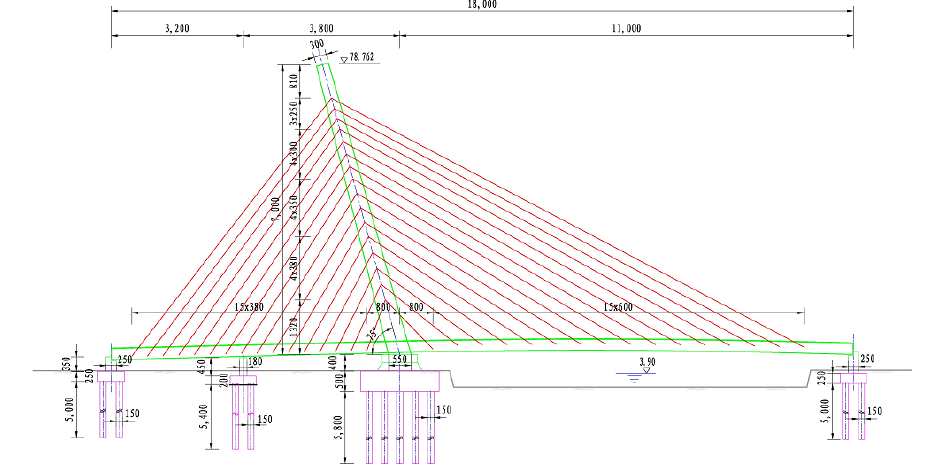
Figure 2. A single tower cable-stayed bridge.